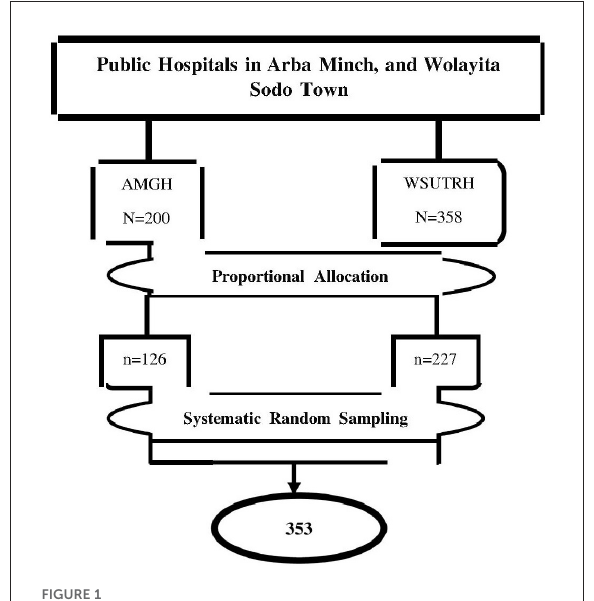
FIGURE1 Schematic presentation of sampling procedures to assess the magnitude and associated factors of second trimester induced abortion women who received abortion services at public hospitals in Arba Minch, and Wolayita Sodo town, southern Ethiopia, 2021. Where: AMGH, Arba Minch General Hospital, WSUTRH, Wolayita Soda University Teaching Referral